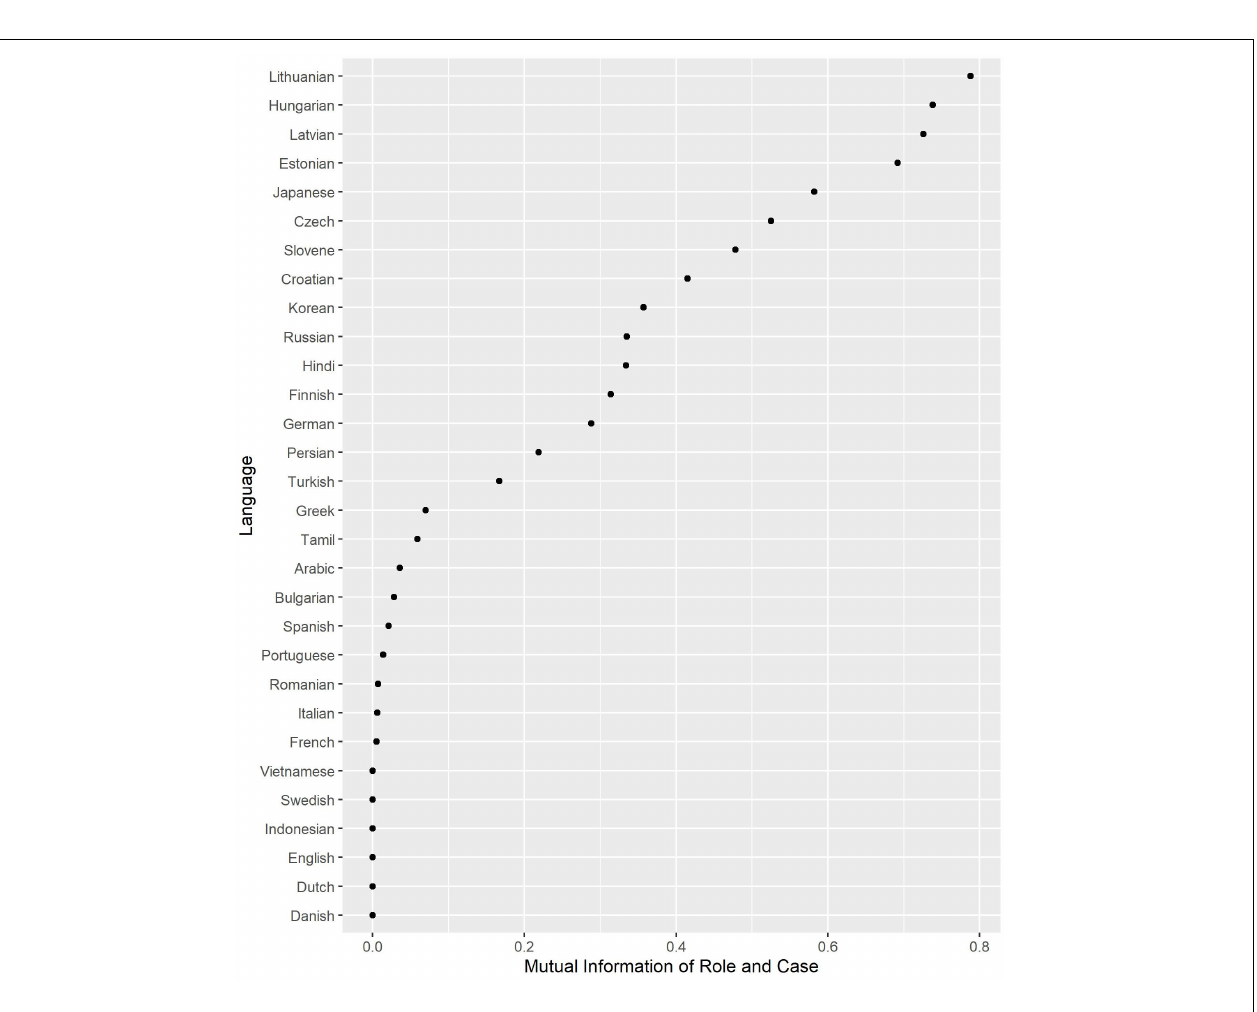
FIGURE 1 | Case marking (Mutual Information between Role and Case).